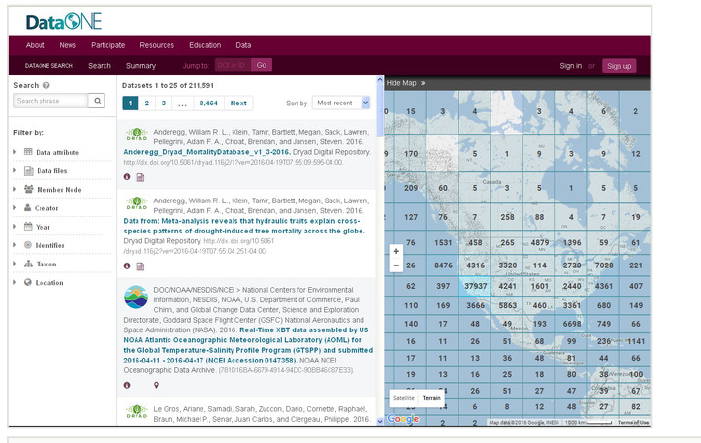
Individual Metacat instances can be connected to DataOne which replicates public fi les. Thus the data is still available if a single instance goes o ffl